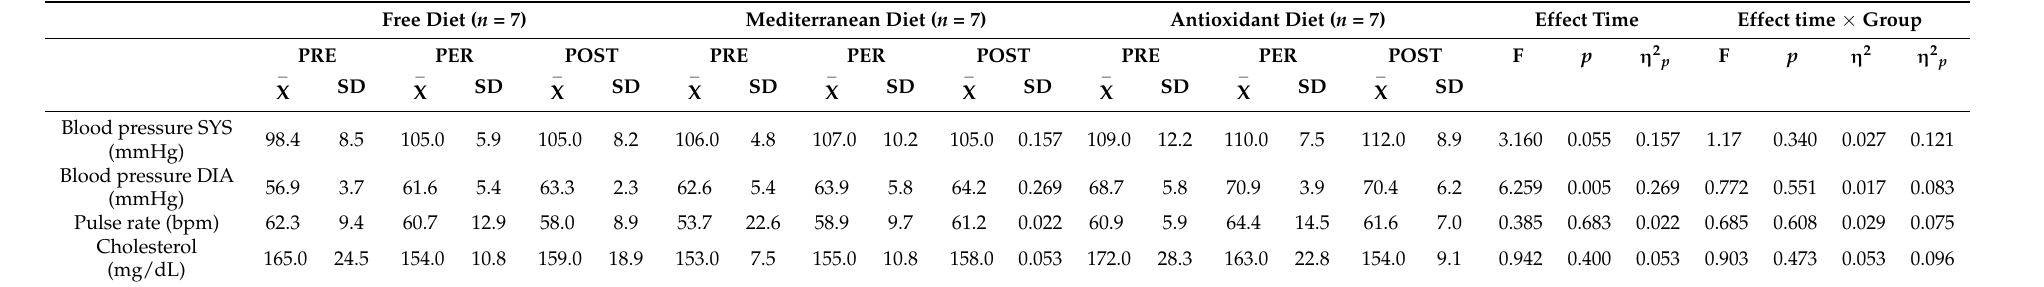
Table 3. Health parameters before, during, and after the intervention of the free diet, Mediterranean diet, and antioxidant-rich diet groups.